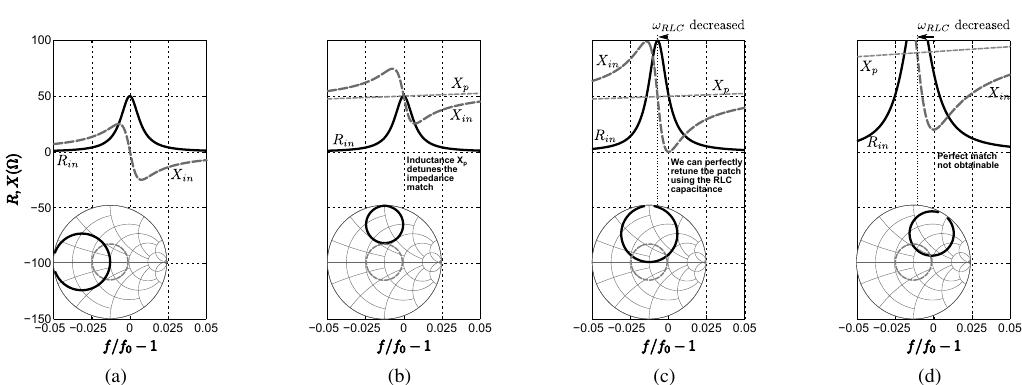
FIGURE 3. Impedance trends of the rectangular patch antenna. (a) Extremely thin substrates ( L p ≈ 0 ). (b) Substrate height increases, and the designer has not reoptimized feed location and resonant frequency. (c) Using capacitive reactance of the RLC circuit to compensate for probe reactance. (d) Probe reactance too great to completely compensate with RLC